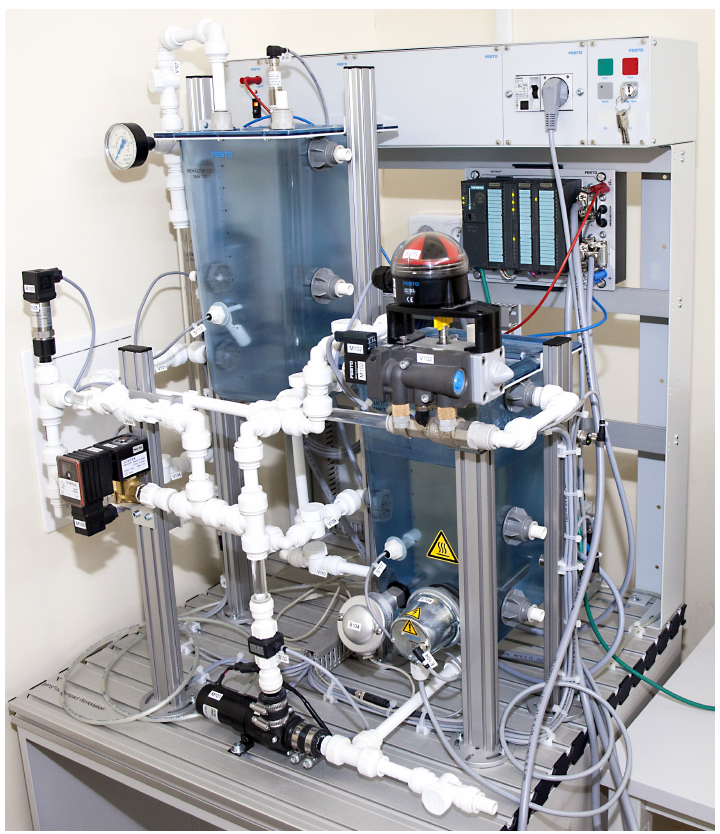
Figure 13. Experimental setup.